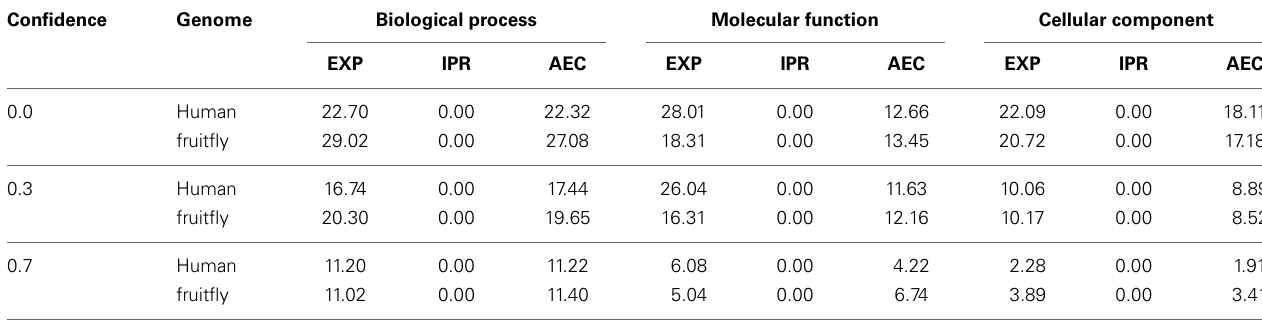
Table 2 | Percentage redundancy of manual and electronic pipelines for different confidence levels. Confidence